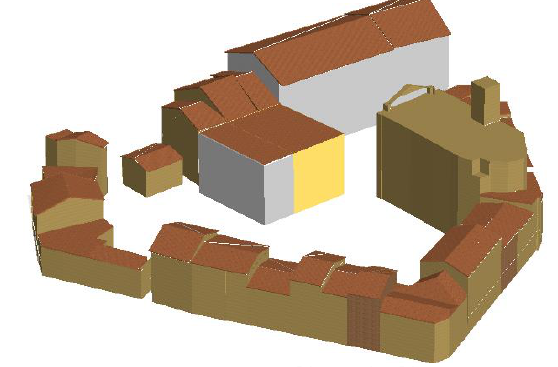
Figure 10. LOD2, Old town buildings